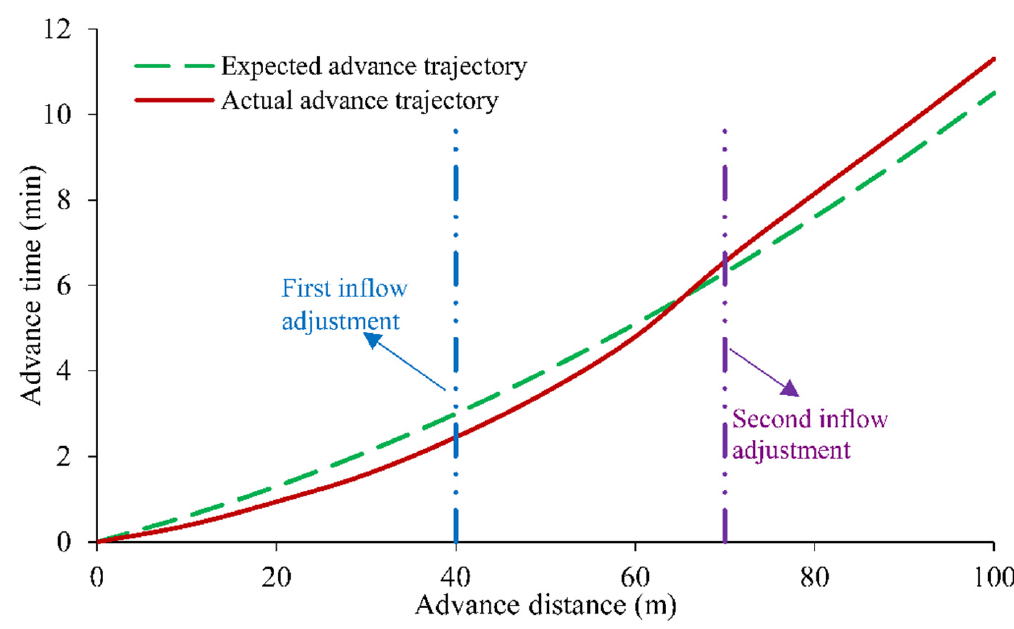
Figure 1. Schematic diagram of improved real ‐ time control irrigation scheme.